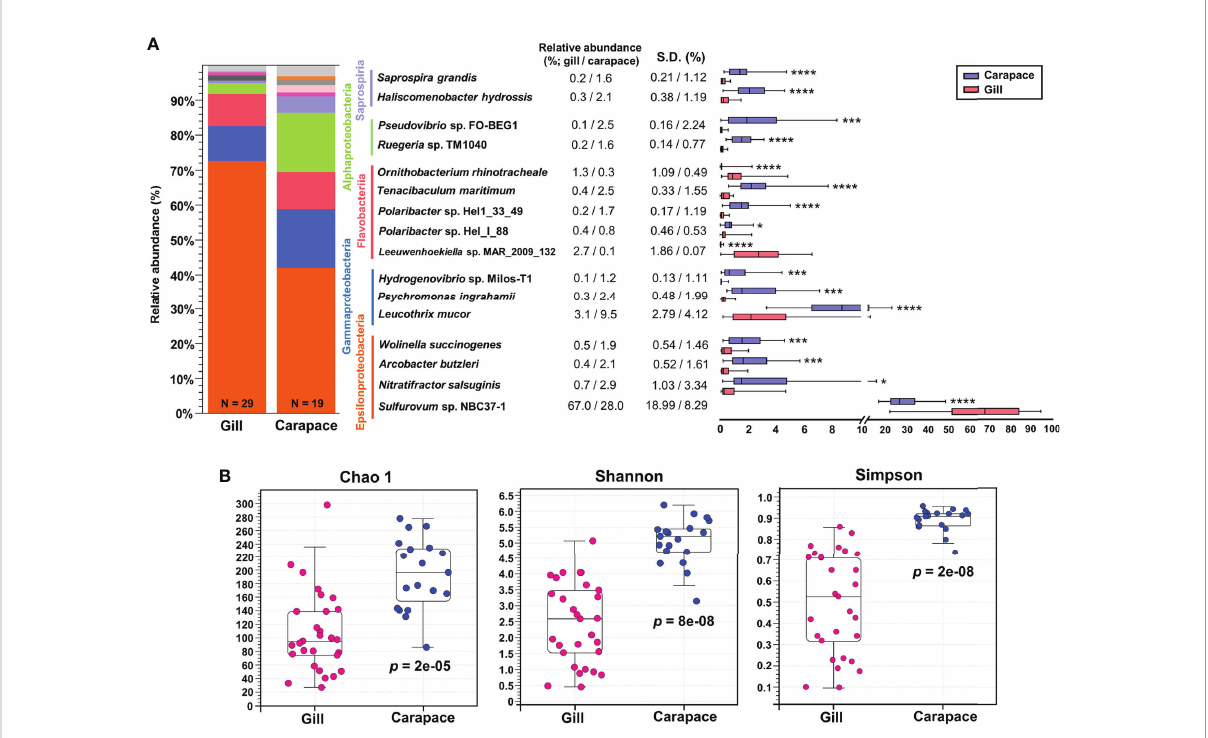
FIGURE 3 Relative abundance and alpha diversity of bacterial species. Box plots and whisker plots (A) illustrate the relative abundance of representative species within the fi ve dominant classes of the gills and carapace surface. Asterisks indicate signi fi cant differences between gill and carapace groups (Welch ’ s t -test; * p < 0.05, *** p < 0.001, **** p < 0.0001; gill, N = 29; carapace, N = 19). The alpha diversity was analyzed at the species level (B) according to Chao 1, Shannon, and Simpson indices (Kruskal-Wallis test, p <